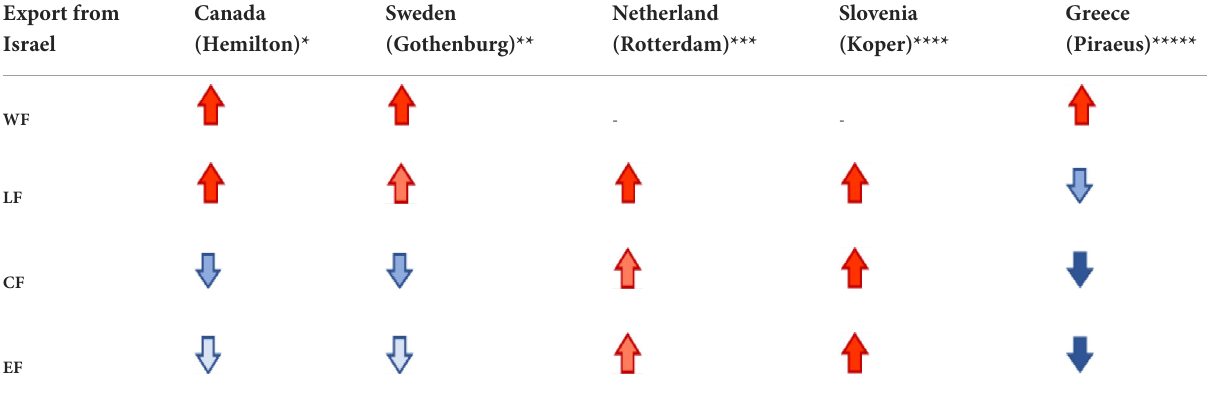
TABLE 1 Estimating the footprint of imported tomatoes compared to local production. Export